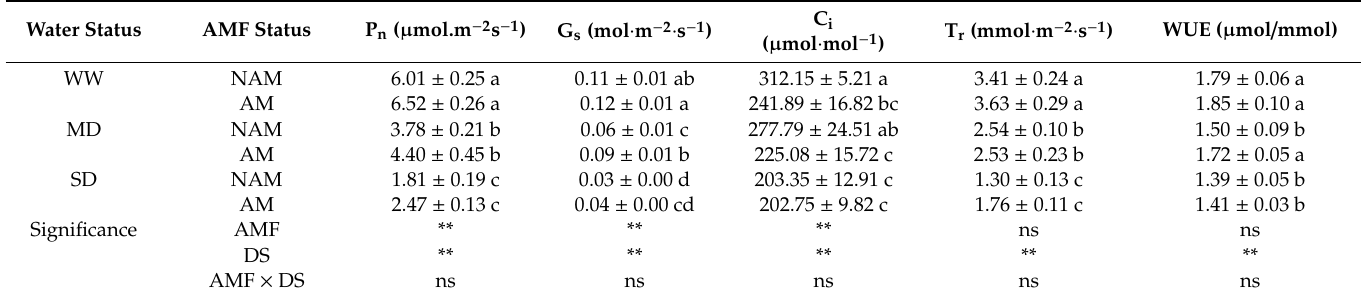
Table 2. E ff ect of the arbuscular mycorrhizal fungus (AMF) Rhizophagus intraradices on the photosynthetic gas exchange parameters of Catalpa bungei seedlings under